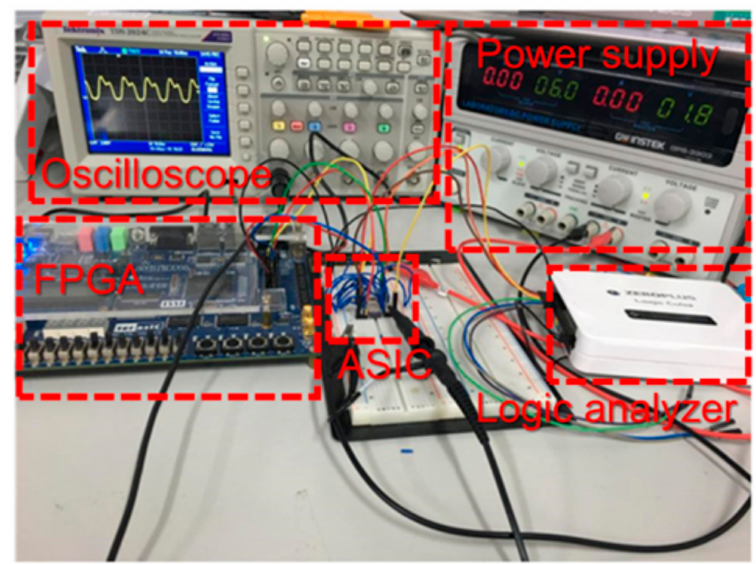
Figure 13. Verification environment that consists of power supply, oscilloscope, FPGA, ASIC, and logic analyzer.